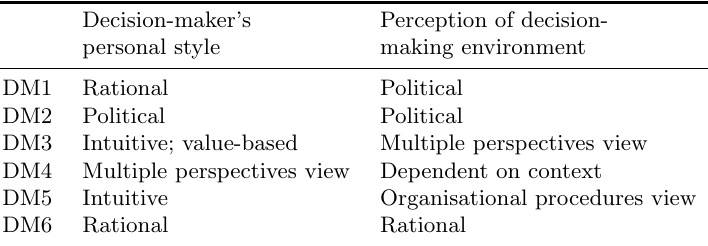
Table 2: Comparison between personal style and perception of decision-making environment.